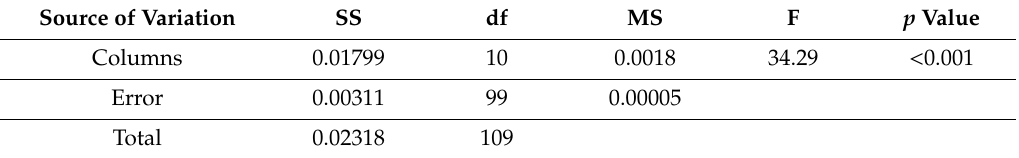
Table 5. One-way analysis of variance test details for the individual classifiers.